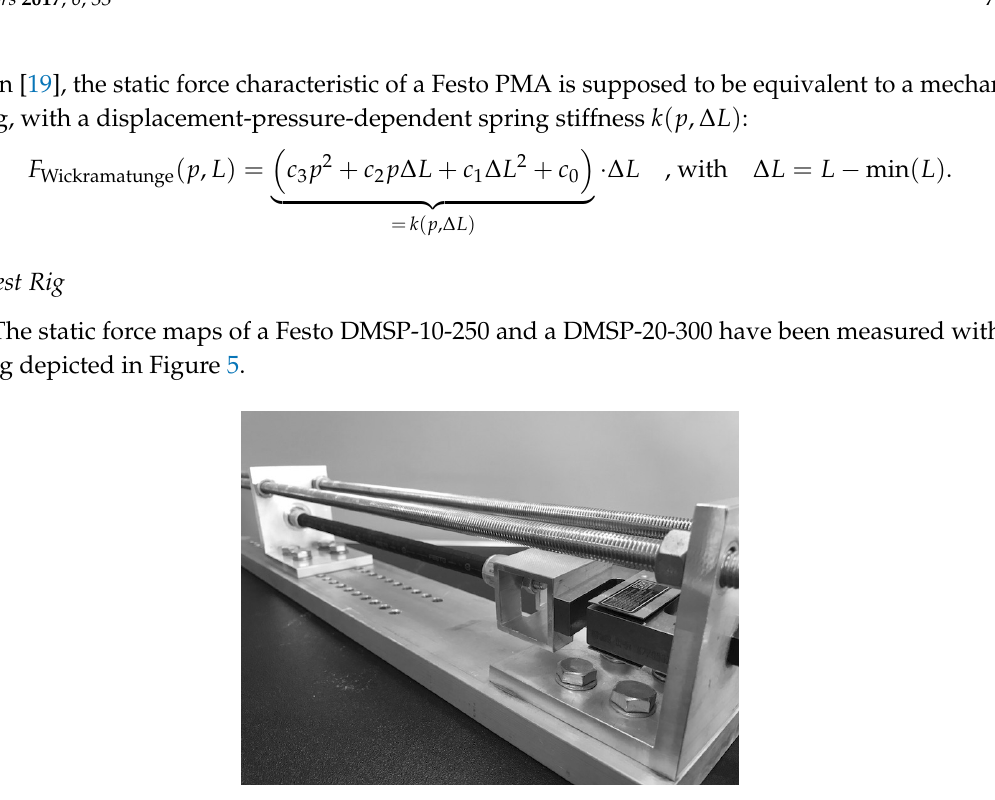
Figure 5. Photo of the test rig that the characteristic force maps have been measured